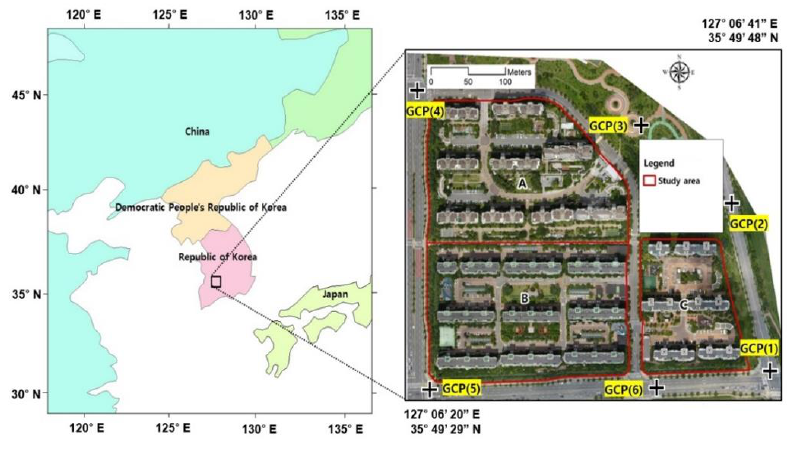
Figure 1. The research process.